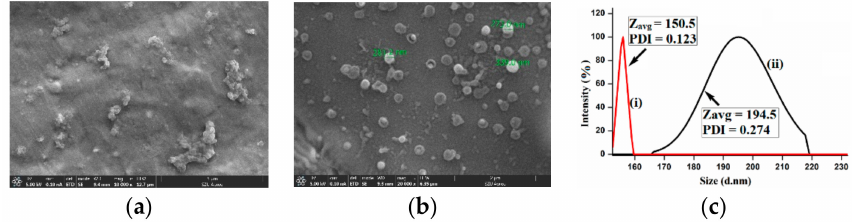
Figure 5. SEM images of ( a ) AIE-1 and ( b ) AIE-2 taken from drop-cast probes in THF-H 2 O (1:9, v / v ). ( c ) DLS-based particle size analysis of AIE-1 in (i) 100% THF and (ii) THF-H 2 O (1:9, v / v ) solvent mixtures. This type of morphology is formed by aggregates of small particles associated with solvent